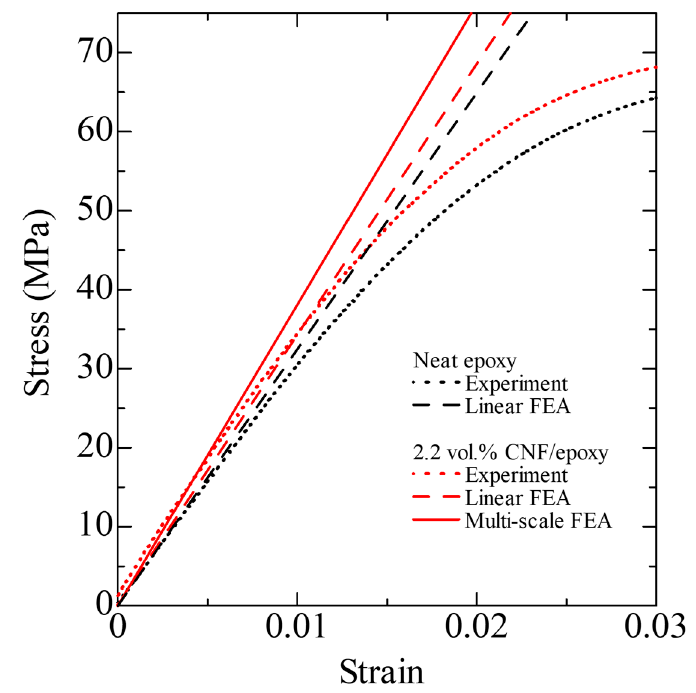
Figure 6. Predicted and experimental stress–strain curves for the neat epoxy and CNF/epoxy composite.